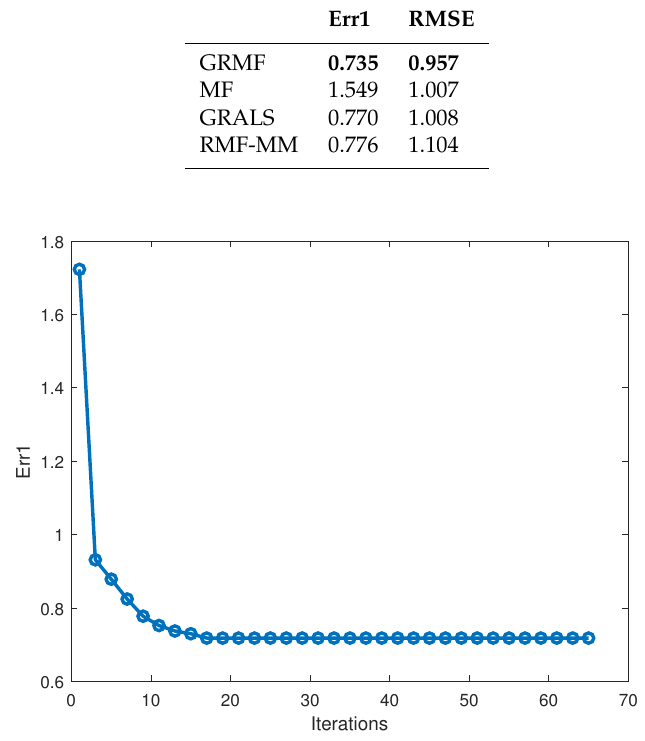
Table 1. Err1 and RMSE on toy dataset.